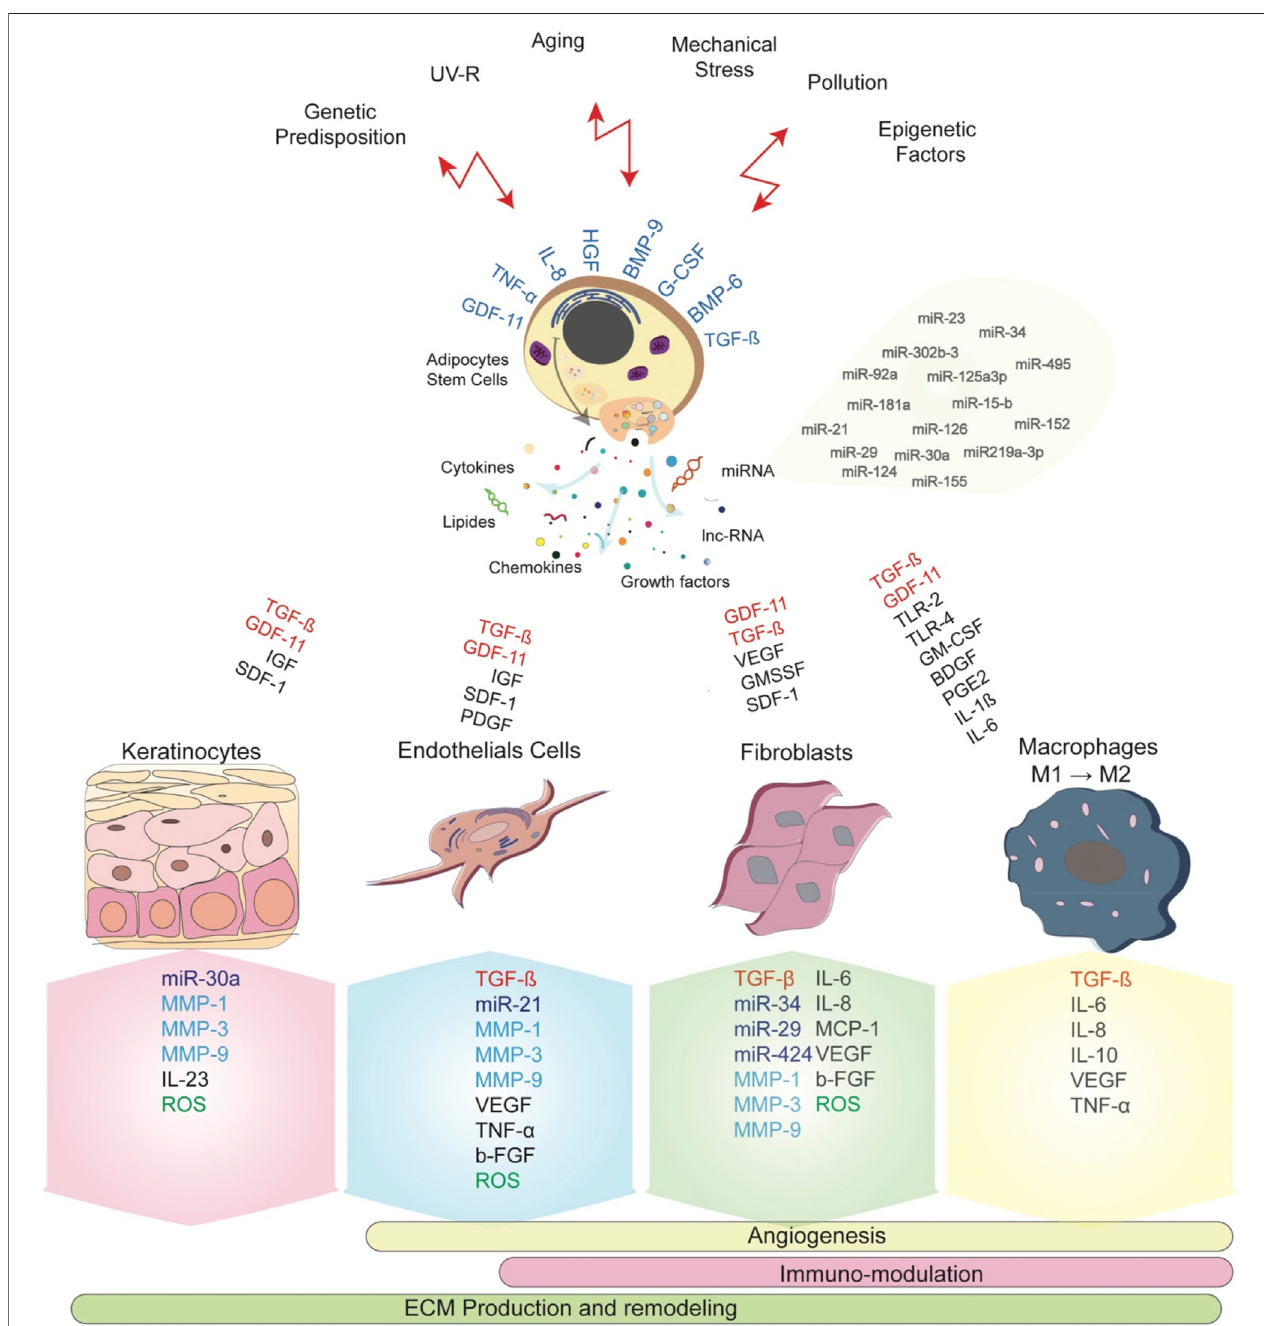
FIGURE 2 | ASCs serve as effective immunomodulators in in fl ammatory environments to promote wound healing and regeneration (Mazini et al., 2021).